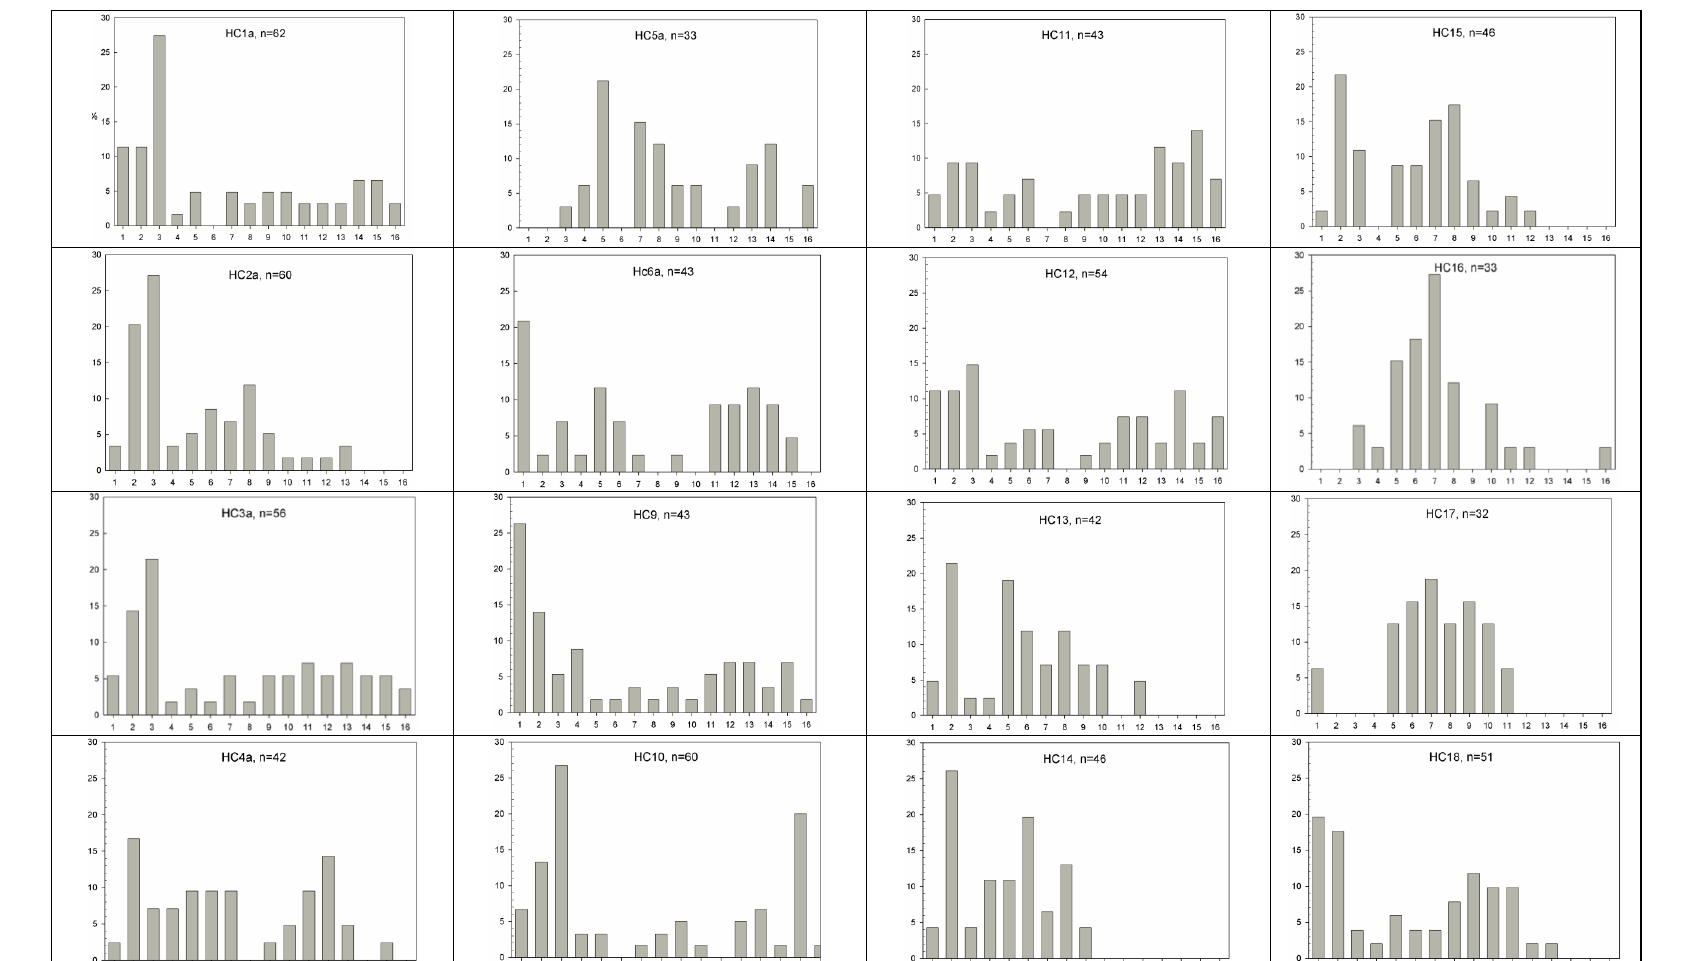
Figure 3. Proportion of H. canterburyana individuals in each height class calculated at each site (%; y axis ). Height classes ( x axis ) 1 = no trunk >0.6 m, 2 = no trunk 0.6 (cid:177) 1.2 m, 3 = no trunk >1.2 m, 4 = trunk <0.5 m, 5 = trunk 0.5 (cid:177) 1 m, 6 = trunk 1 (cid:177) 1.5 m, 7 = trunk 1.5 (cid:177) 2 m, 8 = trunk 2 (cid:177) 2.5 m, 9 = trunk 2.5 (cid:177) 3 m, 10 = trunk 3 (cid:177) 3.5 m, 11 = trunk 3.5 (cid:177) 4 m, 12 = trunk 4 (cid:177) 4.5 m, 13 = trunk 4.5 (cid:177) 5 m, 14 = trunk 5 (cid:177) 6 m, 15 = trunk >6